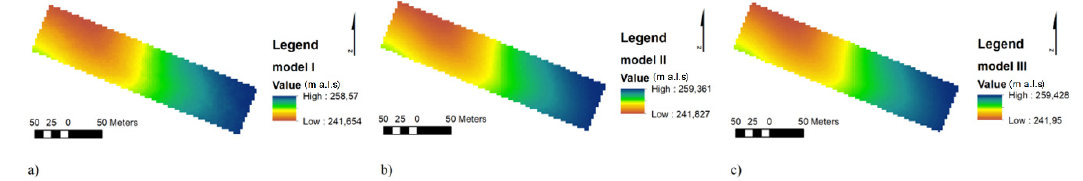
Figure 3. DEM models of the field data generated from: ( a ) aerial photographs, ( b ) aerial laser scans, and ( c ) terrestrial laser scans.